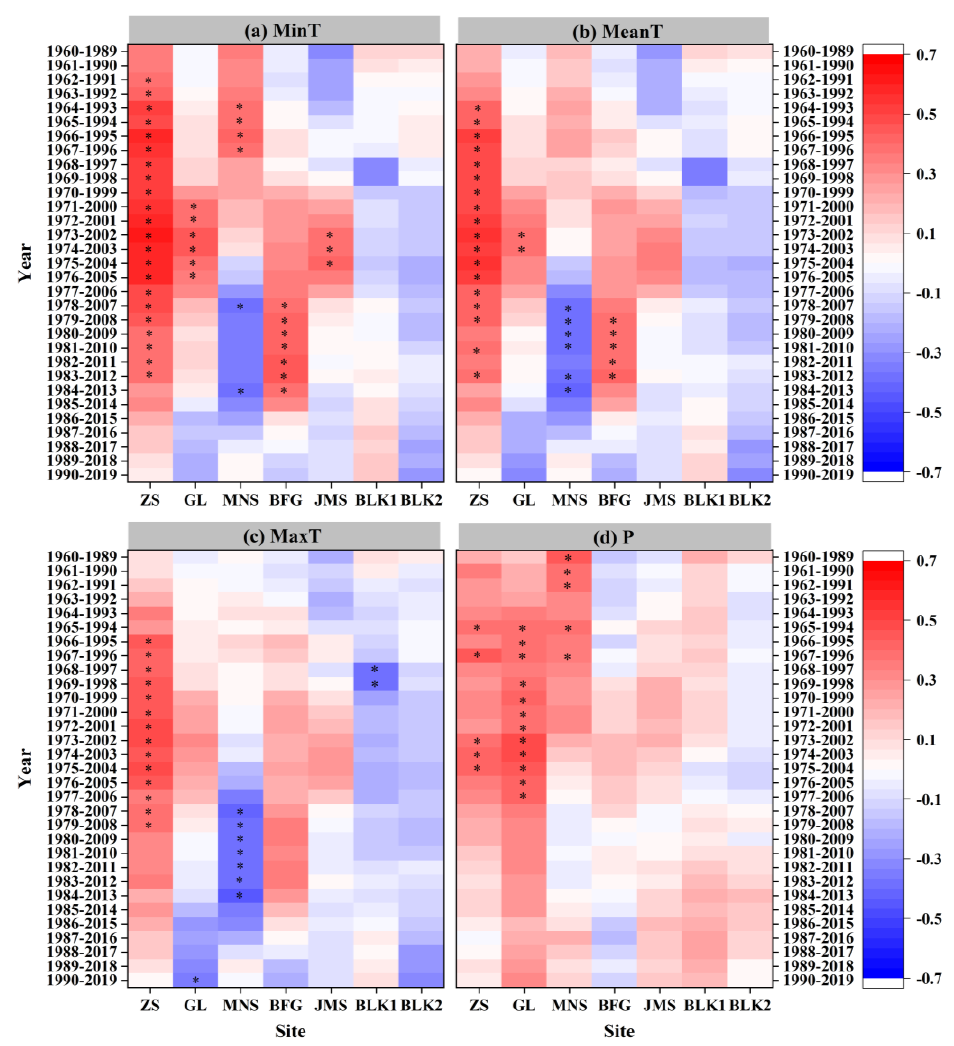
Figure 8. Moving correlation between the tree-ring width chronologies and annual climate factors. MinT: mean minimum temperature, MeanT: mean temperature, MaxT: mean maximum temperature and P: precipitation. Moving window: 30 years. One asterisk represents p < 0.05.